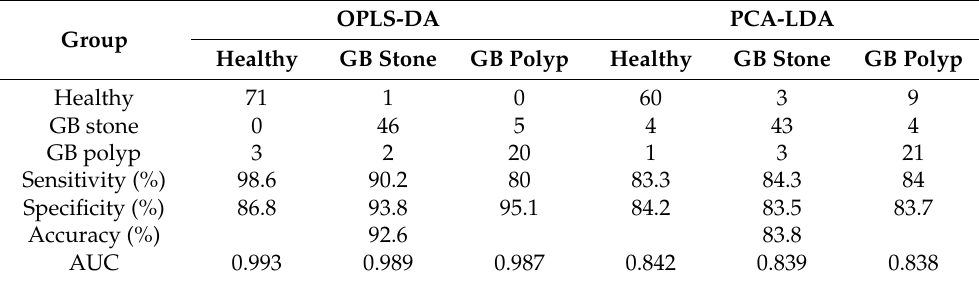
Table 3. The results of triple classification confusion matrix based on OPLS-DA and PCA-LDA analysis. Group